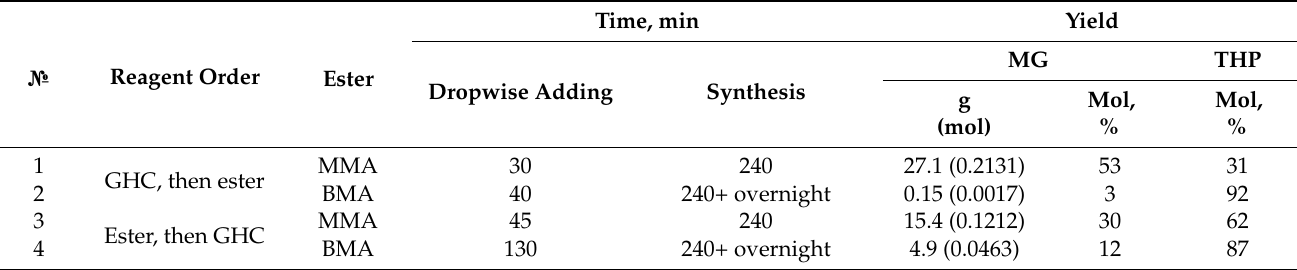
Table 1. Conditions for MG synthesis in DMSO.